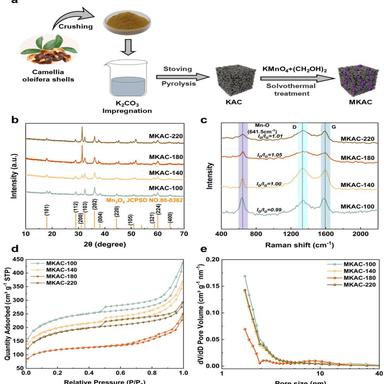
(a)Schematic illustration of the two-step solvothermal synthesis procedure for the MKAC-T materials. (b) XRD patterns, (c) Raman spectra, (d) N2 adsorption–desorption isotherms and (e) pore size distribution of the MKAC-T materials prepared by four different solvothermal temperature.